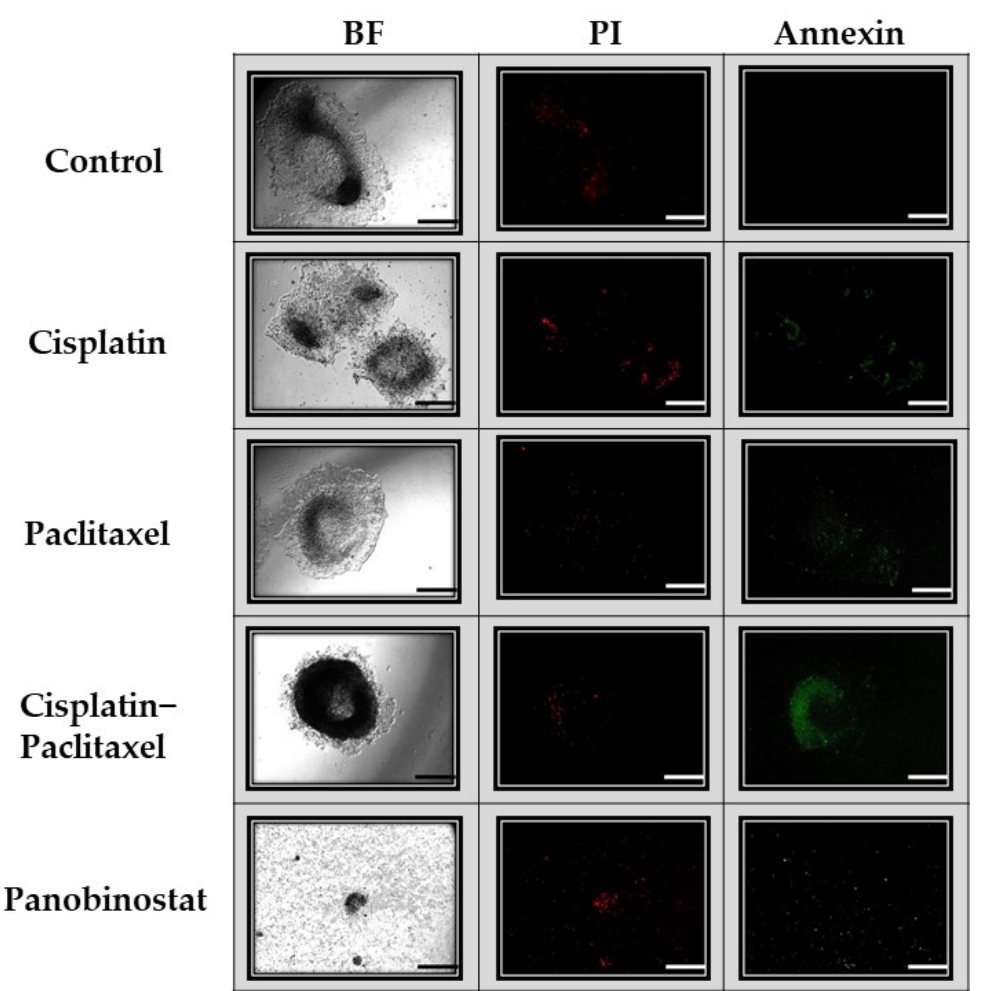
Figure 5. Visual display of apoptosis and necrosis of Caov-3 spheroids on day 7. Caov-3 spheroids were treated and imaged on day 7 with green annexin V staining (apoptosis) and red propidium iodide (PI) staining (necrosis), as well as under bright field microscopy (BF). Under control conditions, after 7 days, the spheroids showed little necrosis and no apoptosis. Spheroids exposed to single-agent chemotherapy (cisplatin alone, paclitaxel alone) demonstrated the same low level of apoptosis and necrosis as the control. Those spheroids exposed to cisplatin–paclitaxel demonstrated the brightest apoptosis staining and little necrosis staining. Spheroids treated with panobinostat had little cellular material left due to the cytotoxicity of the drug; however, what is present demonstrates high levels of apoptosis and necrosis. Scale bar is 100 µm ( n = 2).